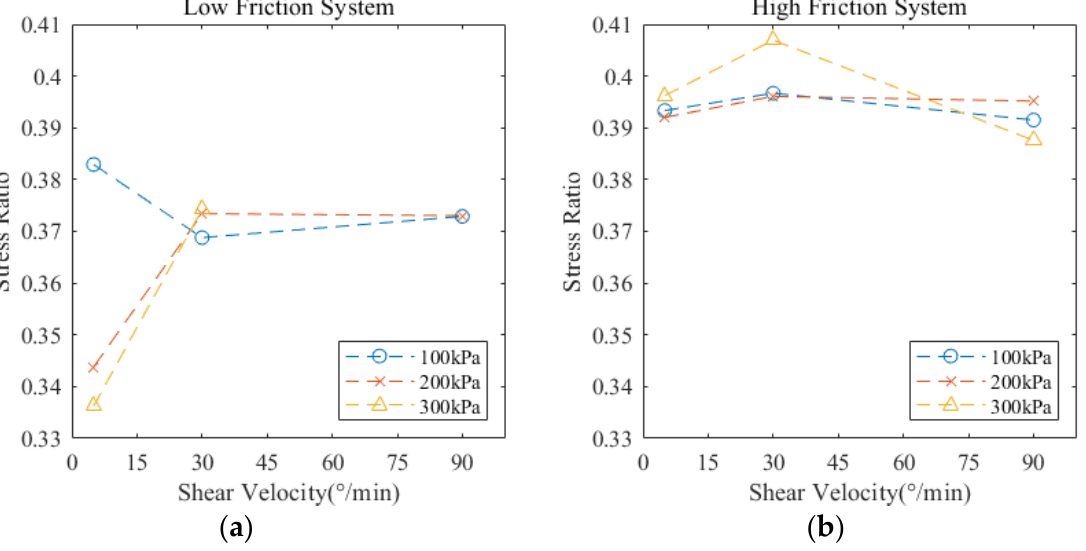
Figure 4. Relationship between shear velocity and stress ratio under different normal stresses. ( a ) Glass bead; ( b ) Spherical corundum.